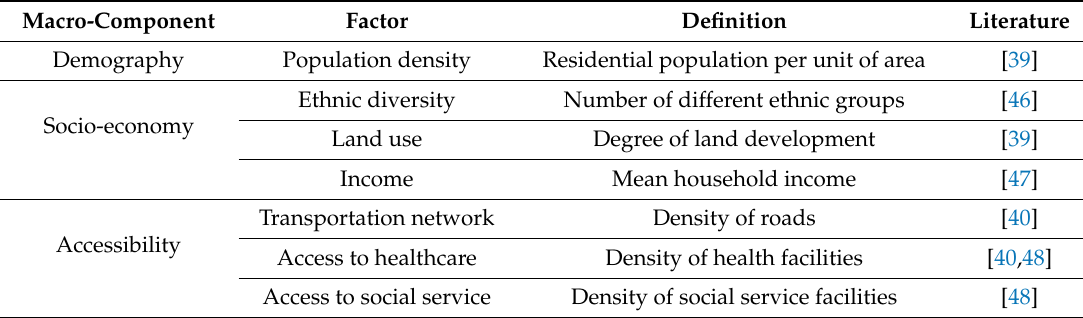
Table A2. Macro-components and factors to define the continuous rurality index